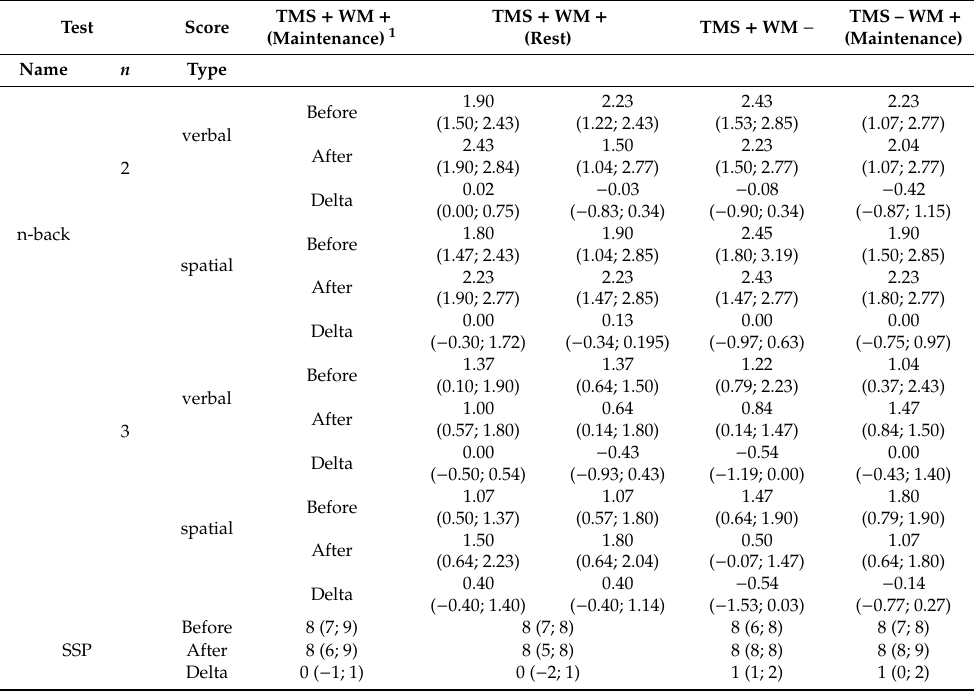
Table 1. Cognitive test scores before and after